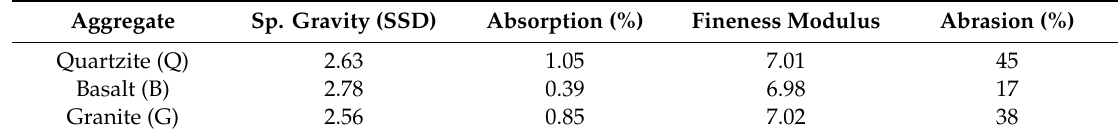
Table 2. Physical properties of coarse aggregates.